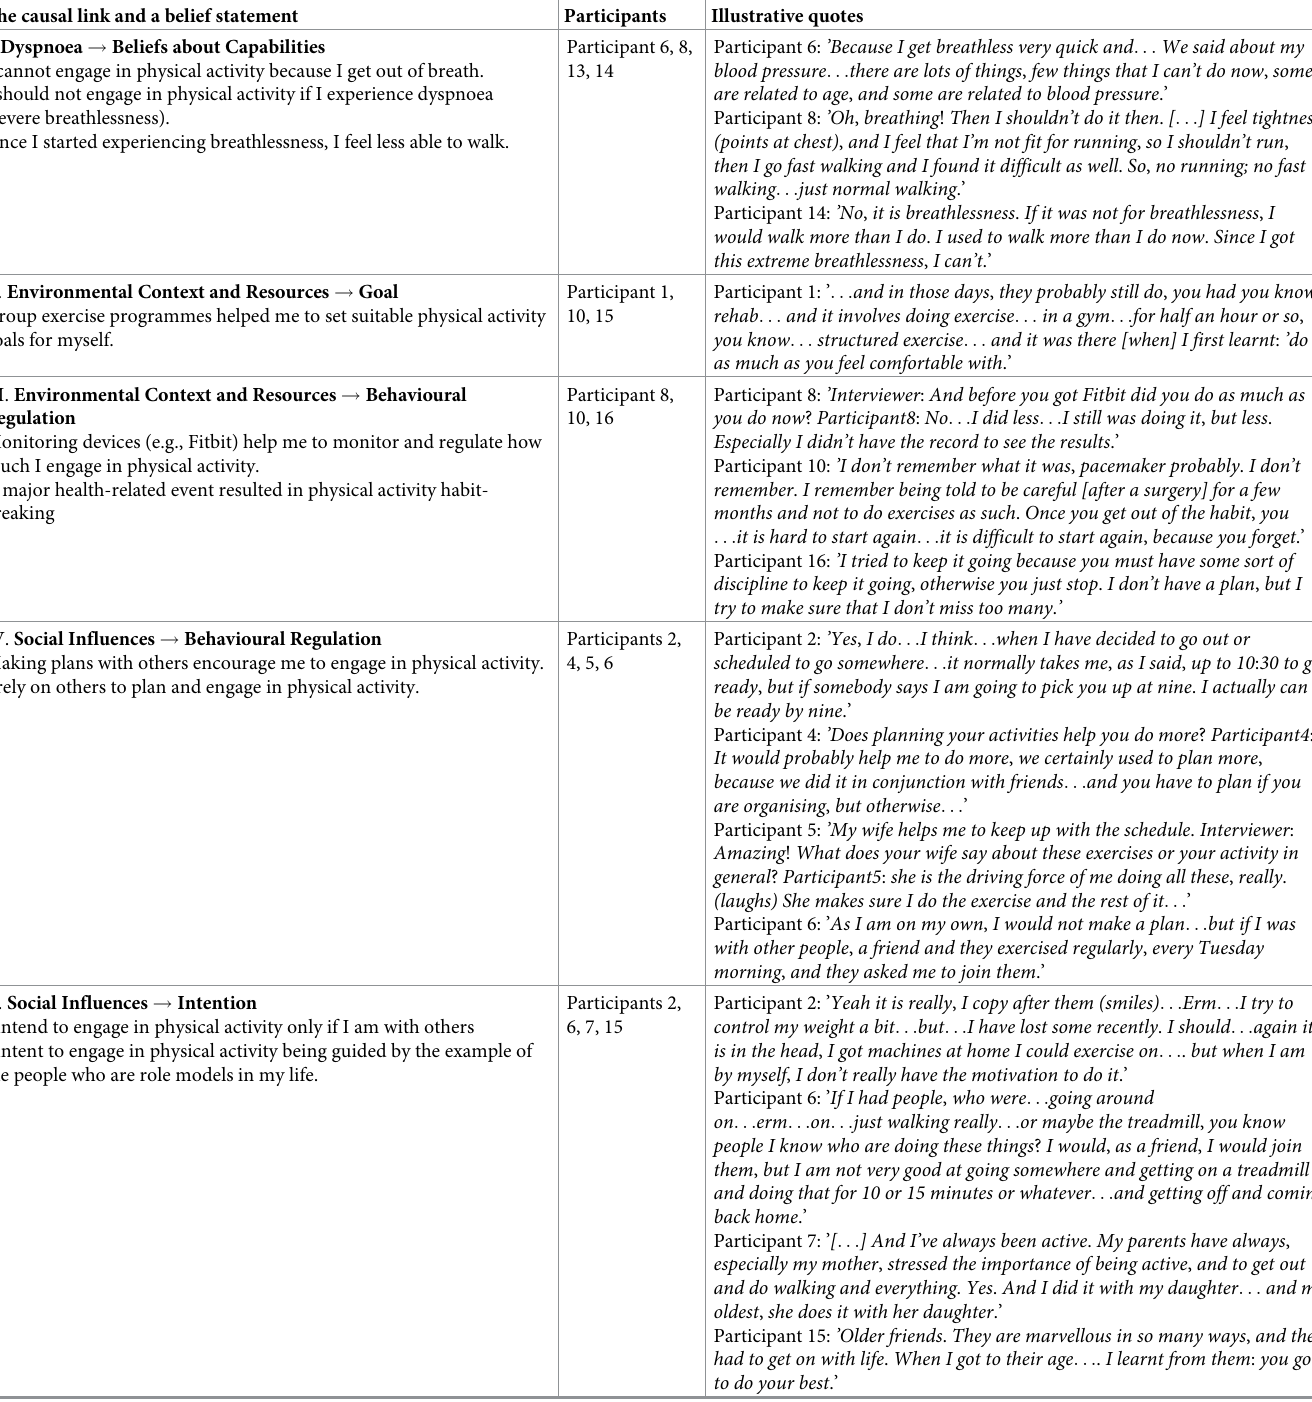
Table 3. The causal links described by at least three participants expressed in a belief